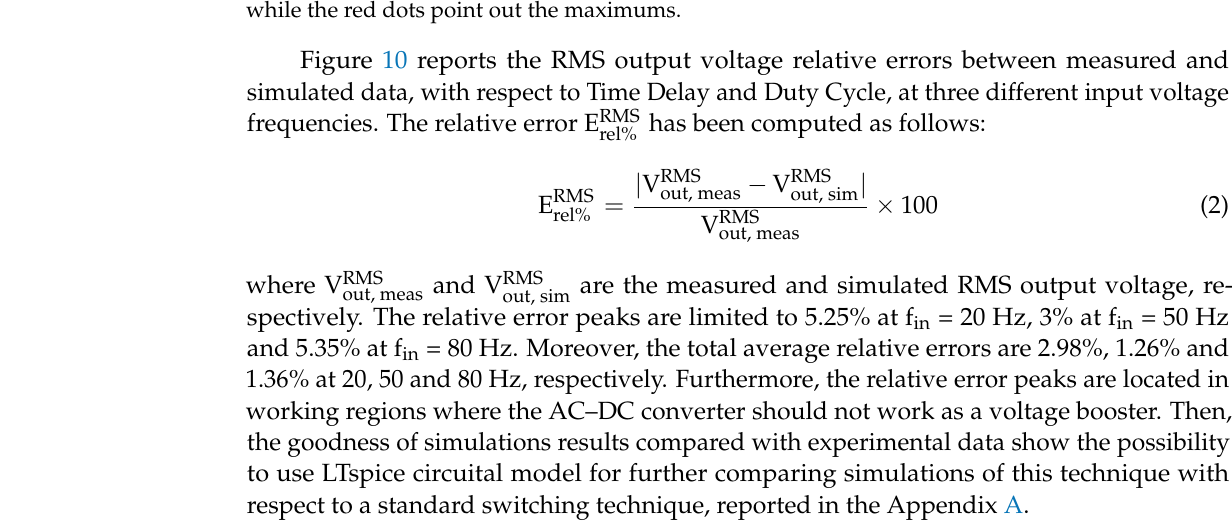
Figure 9. Mapping of the RMS output voltages with respect to the Duty Cycle (D) and Time Delay (T D ), at different frequencies (f in ) of the input voltage. The insets show the top view of each surface, while the red dots point out the maximums.